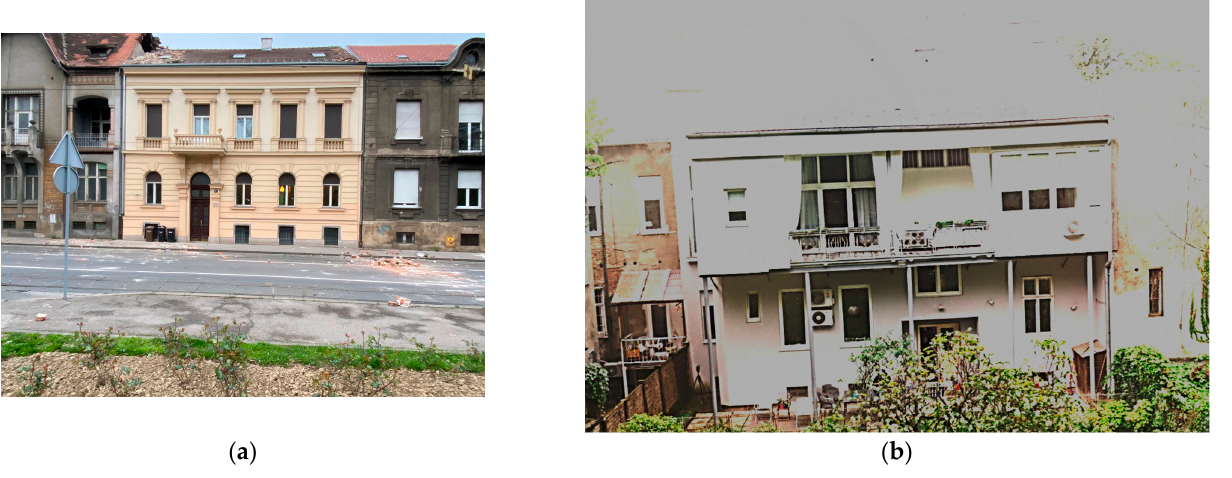
Figure 5. Investigated buildings Ribnjak 44: ( a ) street view (building in the middle); ( b ) courtyard view [32]. Reproduced with permission from Projekt na kvadrat d.o.o.,